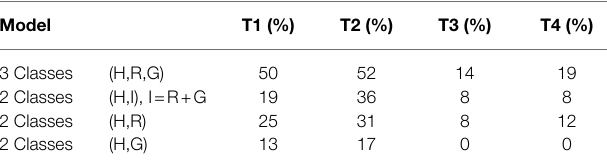
TABLE 3 | PLS-DA classification to distinguish grapevine plants infected by either GFLV or GRSPaV from healthy individuals, over the vegetative season.